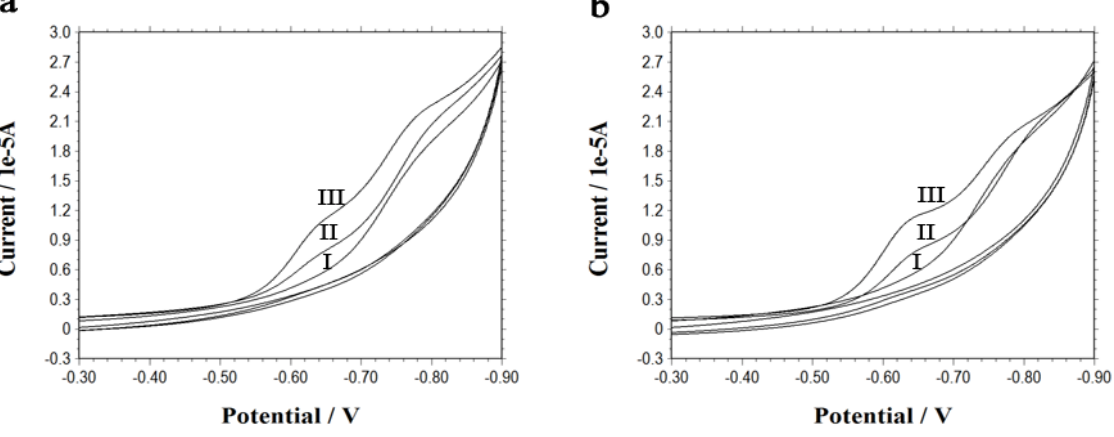
Figure 2. Cyclic voltammograms for a 50 mM Tris-HCl buffer (pH 7.4) obtained at the DNA-modified electrode after its incubation with 22Rv1 cells which were previously pretreated by ( a ) 50 μ M doxorubicin and (I) 0 μ M, (II) 20 μ M, (III) 100 μ M iRGD,